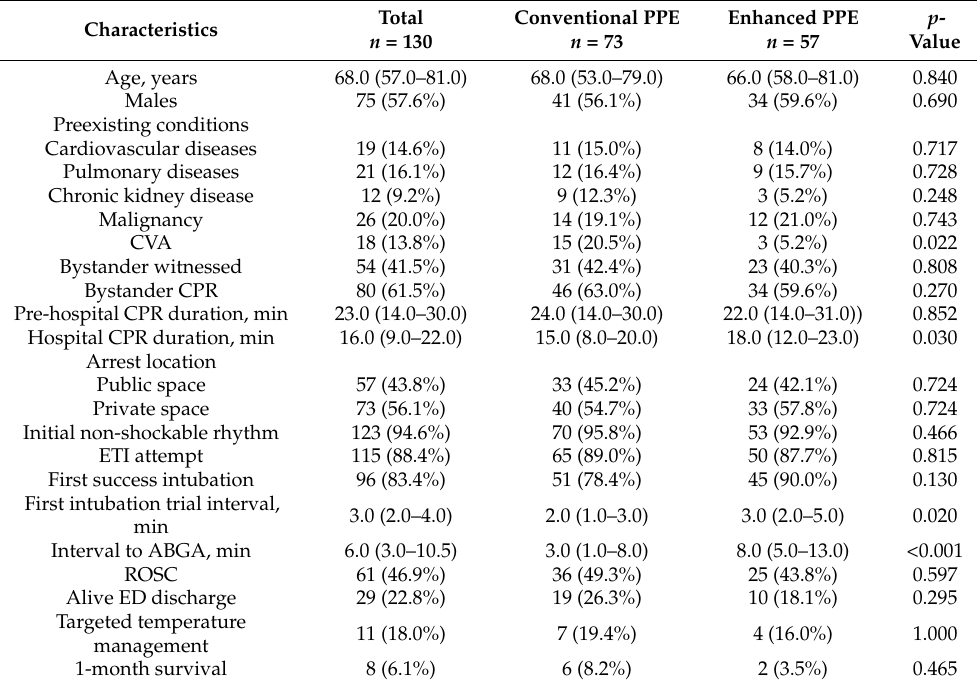
Table 1. Baseline characteristics and outcomes of patients with the use of conventional and enhanced personal protective equipment.